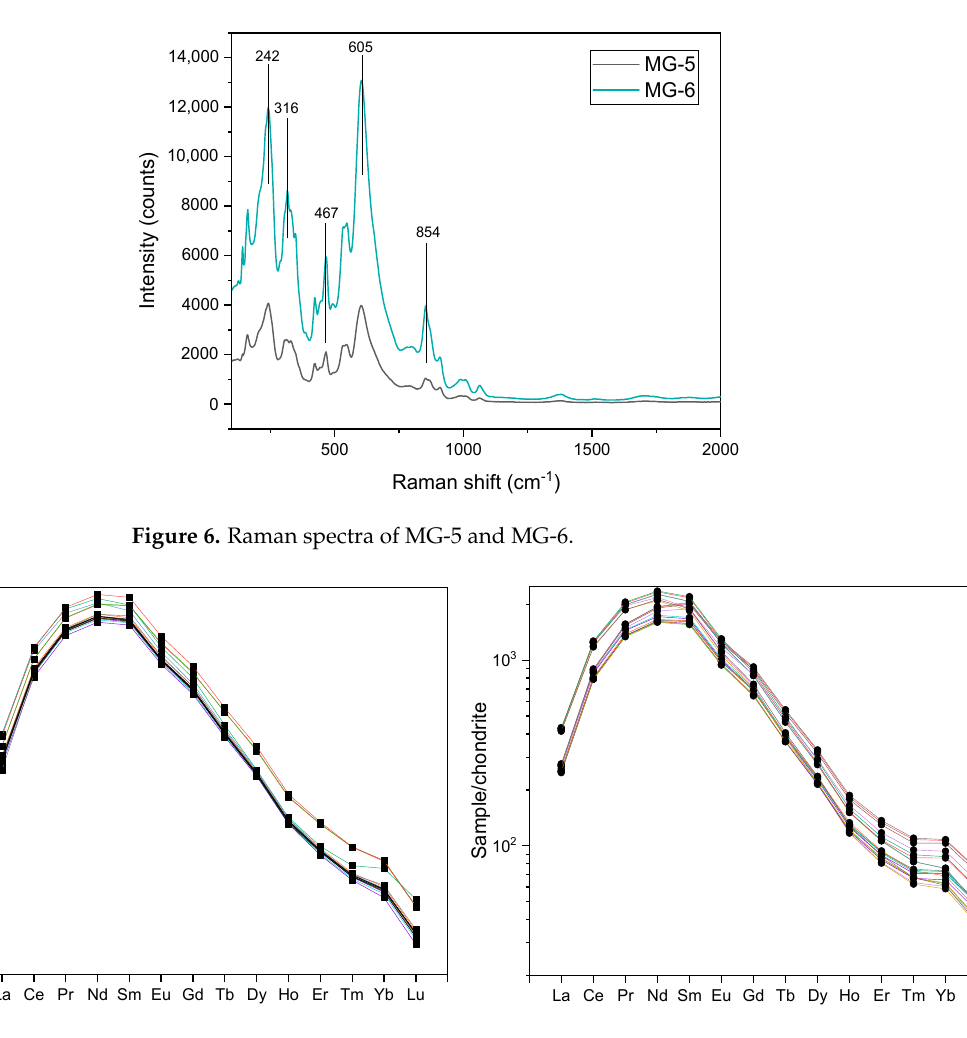
Figure 7. Chondrite-normalised REE patterns of titanite samples MG-5 ( a ) and MG-6 ( b ). Chondrite REE values from McDonough, W.F. and Sun, S.S. (1995) [44]. Lines with different colors represent data of different spots in measurement by LA-ICP-MS.